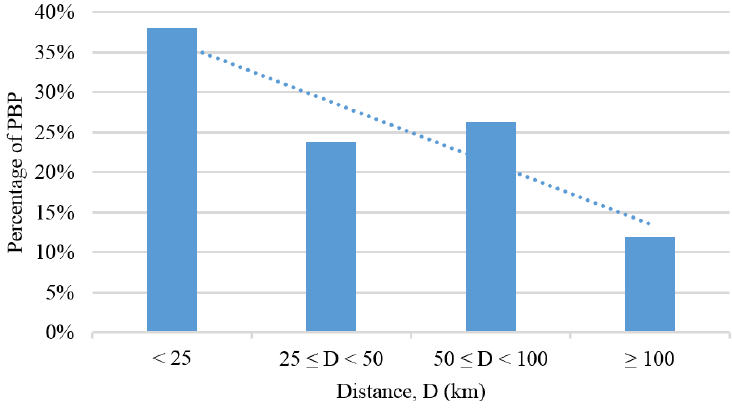
Figure 1. PBP detected according to distance, D (Sample size, N = 42).